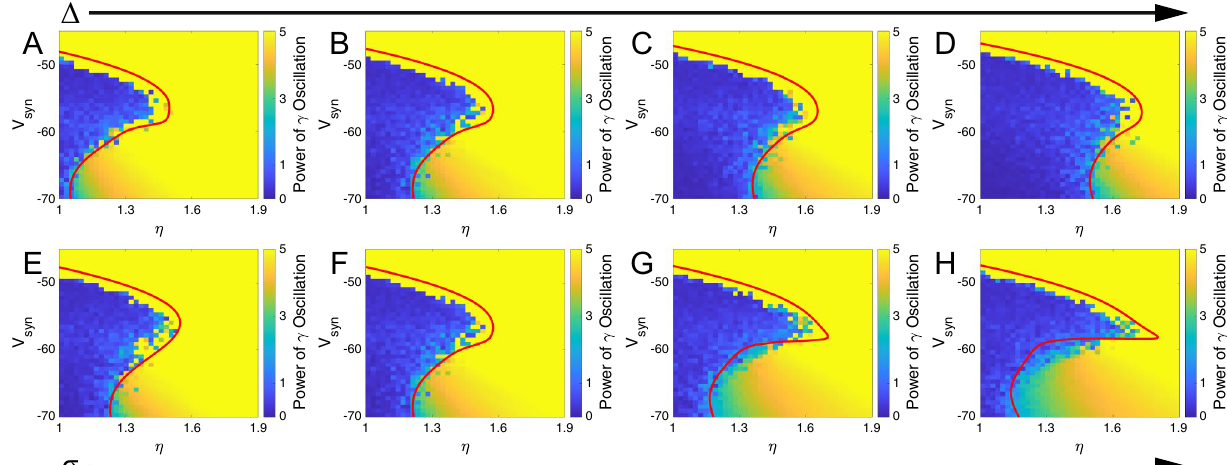
Figure 2. Validation of the bifurcation analyses in ( η , V syn ) plane. The red curve in each figure is the boundary of the stationary state region and limit-cycle oscillation state region, obtained from the two-cumulant macroscopic model [Eqs. (2), (3) and (4)]. The heatmap background in each figure represents the power of gamma oscillation [ P ′ γ ] obtained from the numerical simulation of the microscopic model [Eqs. (1) and (2)]. Note that ( B ) and ( F ) are the same figures with [ (cid:31) = 0.04 , σ = 0.1 ] serving as the home position. ( A )–( D ) represent the increase in (cid:31) . ( E )–( H ) represent the increase in σ . All numerical simulations of the microscopic model are generated by MATLAB (2019b, http:// www. mathw orks. com/ produ cts/ model [Eqs. (1) and (2)]. To obtain the total frequency power, we perform a fast Fourier transform to the time-course of [ g syn ] and integrate the power spectral density over the frequency domain of gamma oscilla- tion (30–200 Hz). To normalize the power difference between stationary points and oscillatory points and avoid negative value, we adjust the integration of power spectral density P γ by introducing a transformation P ′ γ = ln ( 10 4 P γ + 1 ) . The value used to plot heatmaps in Figs. 2 and 3 is the integration of P ′ γ over the frequency band of gamma oscillation (30–200 Hz). The power spectrum is showed in Supplementary Material Fig. S4. Fig. 2A–D represent the effect of increasing heterogeneity (cid:31) , with values: 0.03, 0.04, 0.05 and 0.06, respectively. Figures 2E–H represent the effect of increasing magnitude of noise σ with values: 0, 0.1, 0.2, 0.25, respectively. The parameter settings in Figs. 2A–D are same as in Figs. 1A, 2E–H are same as in Fig. 1F. Although there are some randomly scattered dots near the boundary of the two regions due to the effect of noise in the numerical simulation, these heatmaps and curves achieve an excellent agreement, indicating the correctness of the bifur- cation diagrams shown in Fig. 1A,F. Besides, we found that the center frequency of oscillation monotonically increases with V syn in a wide frequency range, which includes both lower gamma and higher gamma range. (Supplementary Material Fig. S4). Distinct roles of heterogeneity and noise in ( P syn , V syn ) plane. We next investigate the role of heter- ogeneity and noise in the ( P syn , V syn ) plane, and consider the rate of random synaptic connection P syn . Figure 3A represents the effect of heterogeneity (cid:31) . When we keep the magnitude of noise σ = 0.1 fixed, with the increase of heterogeneity (cid:31) , the regions inside the curves shrink, which enlarges the stationary state region, similar to Fig. 1A. With any given V syn , the oscillatory region of P syn monotonically shrinks. Figure 3B shows the role of noise in ( P syn , V syn ) plane. When we keep the heterogeneity (cid:31) = 0.02 fixed, shown as Fig. 3B, with increasing magnitude of noise σ , the curves twist and regions rotate. By further analyzing the nontrivial rotation, it is shown that the oscillatory regions of P syn are dependent on V syn . When increasing V syn , the oscillatory regions of P syn move rightward, while keeping the area of oscillatory region. The validation of bifurcation analyses in the ( P syn , V syn ) plane is shown in Figs. 3C–E and F–H, which are plotted by the same method as Fig. 2. Figure 3C–E represent the effect of increasing heterogeneity (cid:31) with values: 0.015, 0.02, 0.025. Figure 3F–H represent the effect of increasing magnitude of noise σ with values: 0, 0.01, 0.02. Note that Fig. 3C,G are the same figures under [ (cid:31) = 0.02 , σ = 0.1 ], serving as the home position. Considering heterogeneity (cid:31) alone, the agreement of heatmaps and curves in Fig. 3A,C–E is excellent, showing the gradually shrinking oscillatory region with increasing (cid:31) . In terms of magnitude of noise σ , shown as Fig. 3B and F–H, one observes a clear rotation phenomenon of the oscillatory region in the heatmaps just as predicted by the bifurca- tion curves. This means that in some regions, gamma oscillation emerges with increasing noise, while in some other regions it stabilizes. Although there is some considerable difference between bifurcation diagrams and heatmaps due to finite size effect of numerical simulation, especially in Fig. 3H, the qualitative rotation effect can be clearly observed. Besides ( η , V syn ) plane and ( P syn , V syn ) plane, we also investigated ( η , P syn ) in Supplementary Material Fig. S5, by bifurcation analysis of the two-cumulant macroscopic model [Eqs. (2), (3) and (4)] and numerical simulation of microscopic model [Eqs. (1) and (2)]. The result showed an agreement between macroscopic and microscopic